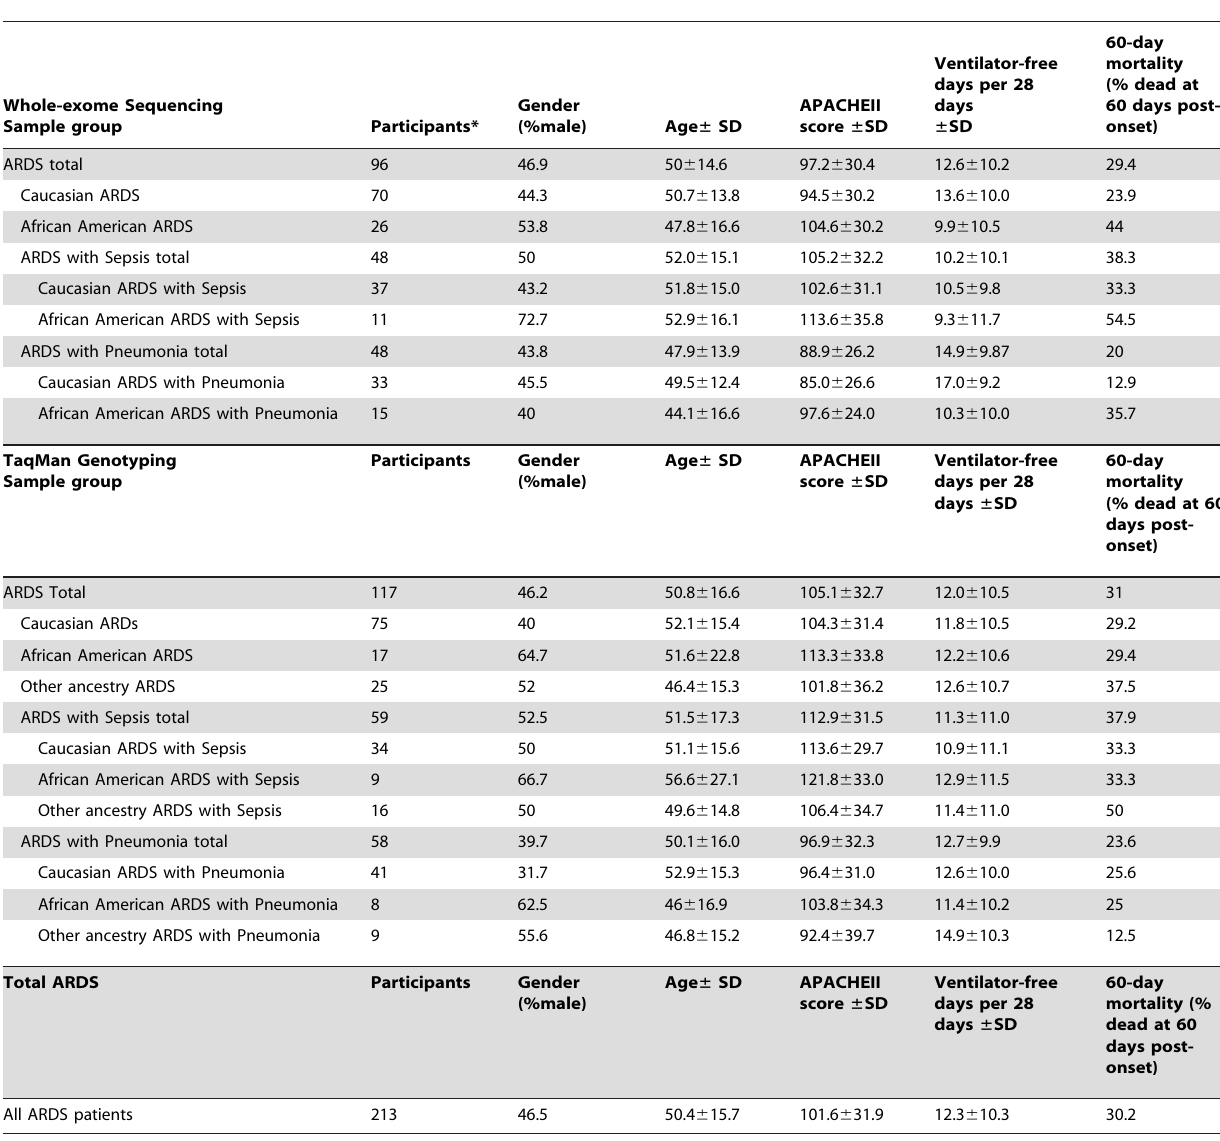
Table 1. Participant demographics and comorbidities for the ARDS